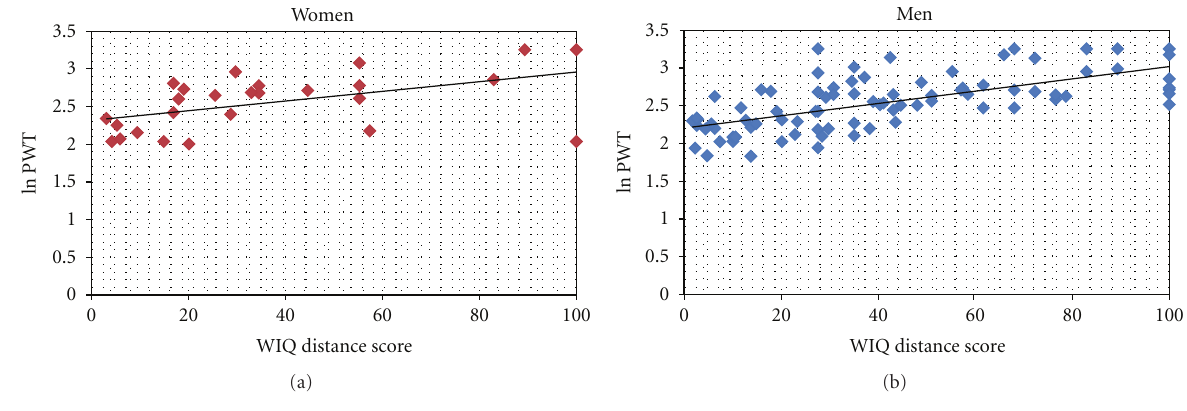
Figure 2: Distribution of WIQ distance scores by PWT within men and women.